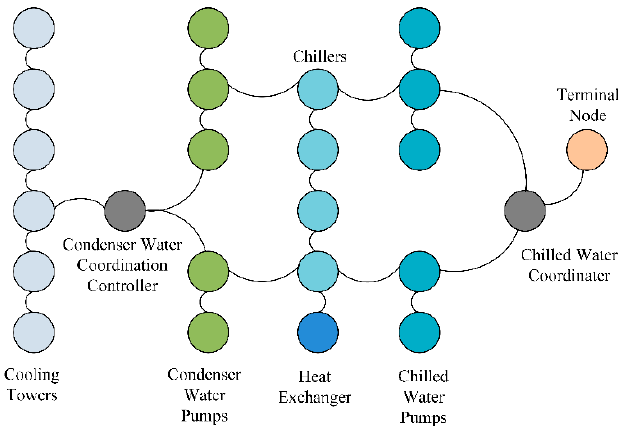
Figure 7. Topological diagram of intelligent device with decentralized control.